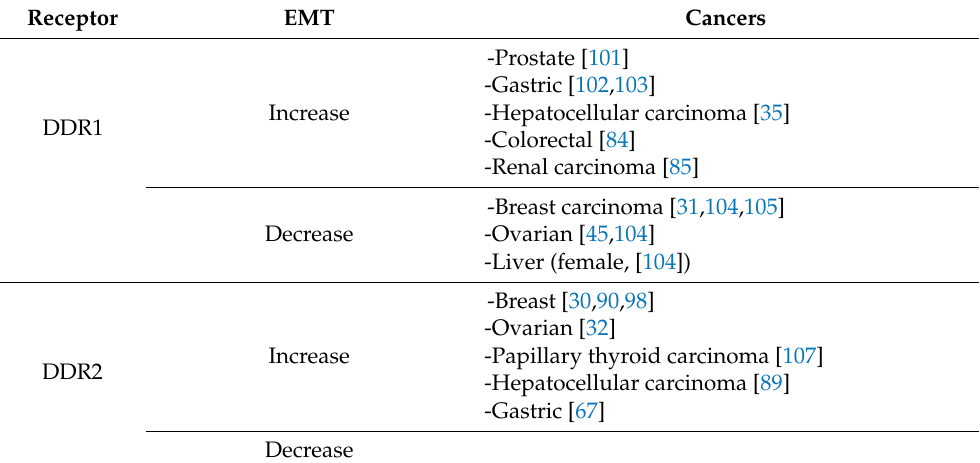
Table 3. Roles of DDRs in the mechanism of